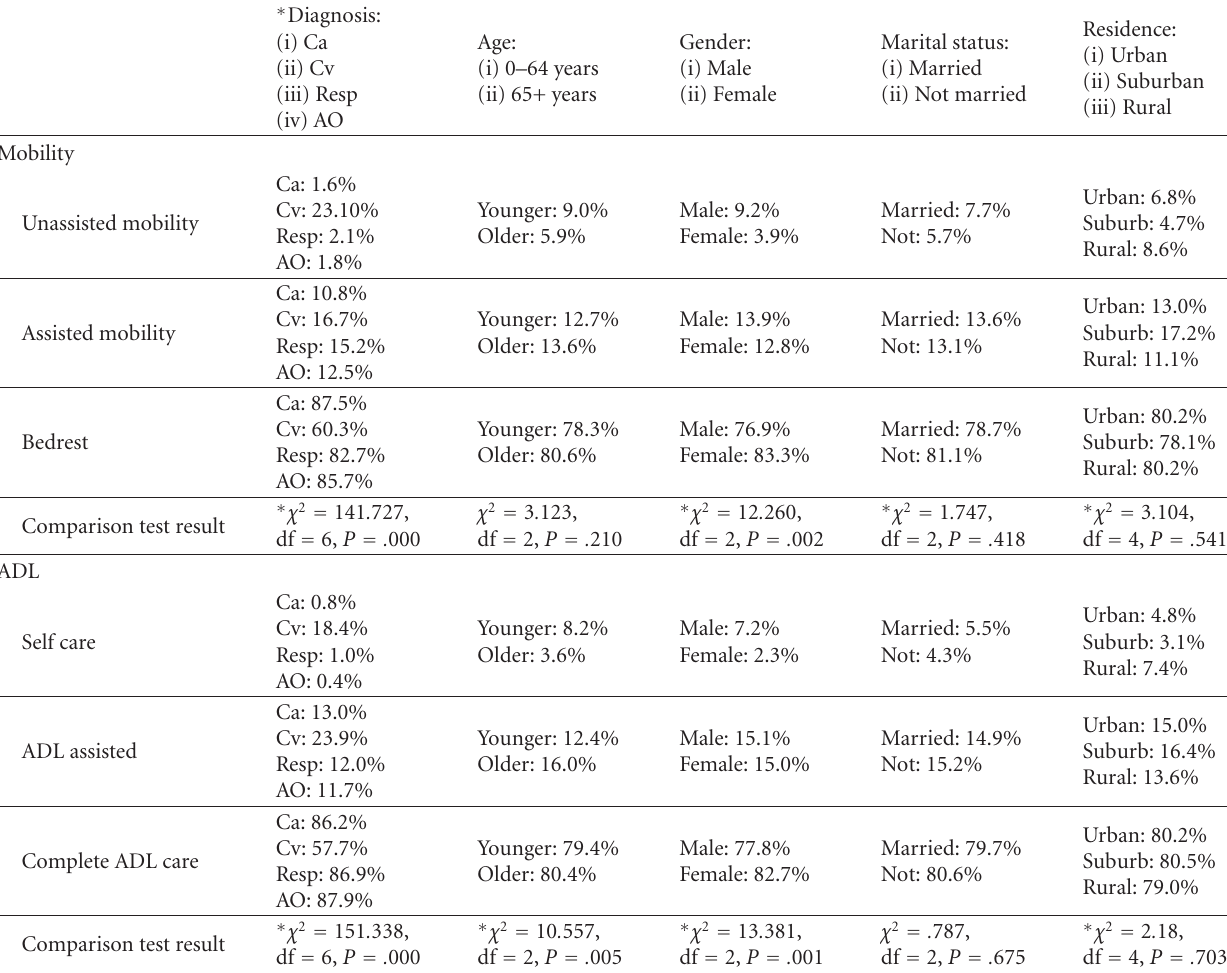
Table 2: Comparative findings in relation to mobility and activities of daily